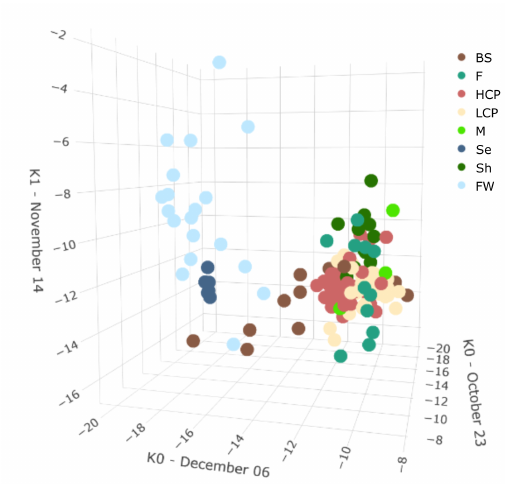
Figure 9. Scatter plot displaying the mean value of the reference objects for the land cover classes: bare soil (BS), fen (F), high-center polygon (HCP), low-center polygon (LCP), meadow (M), sea (Se), shrubs (Sh), and fresh water (FW). The x-y-z axes represent the highest-ranked predictors for the Kennaugh element classification scheme KE C1 (Figure 8). For interpretation of the 3D plot, the reader is referred to the web version of this